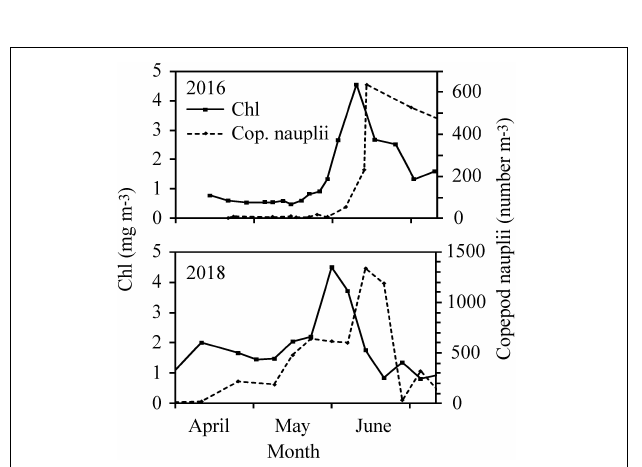
FIGURE 7 | Chl and abundance of copepod nauplii at station S in 2016 and 2018.